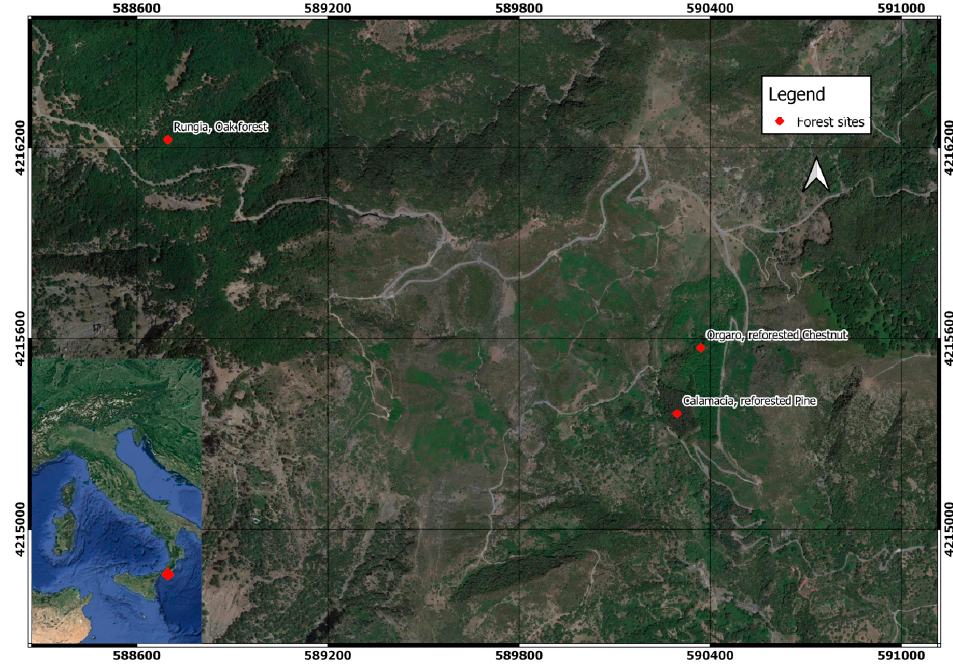
Figure 1. Location of the experimental site (Samo, Calabria, Southern Italy).